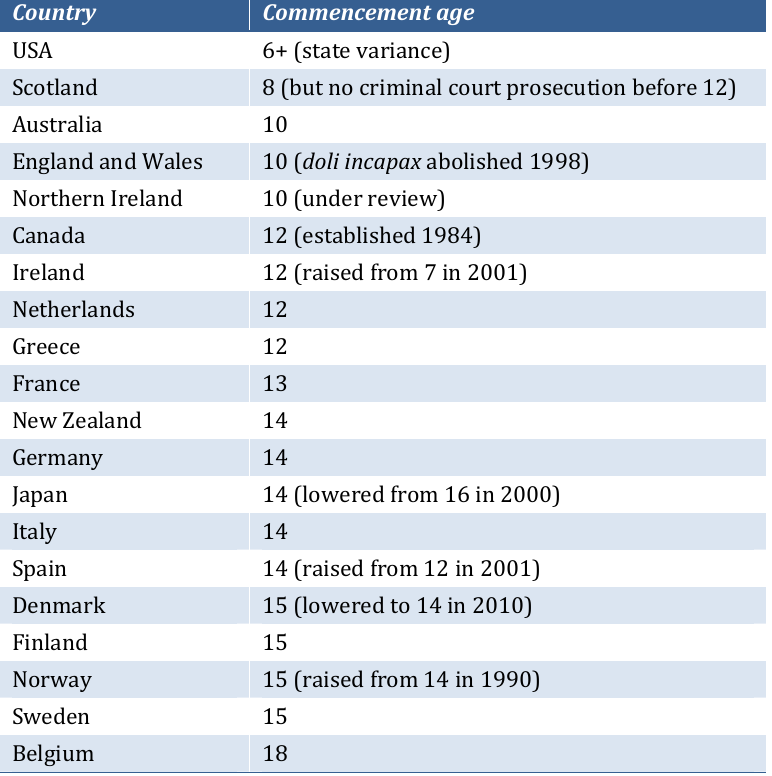
Table 5: Variance in ages of criminal responsibility (selected countries